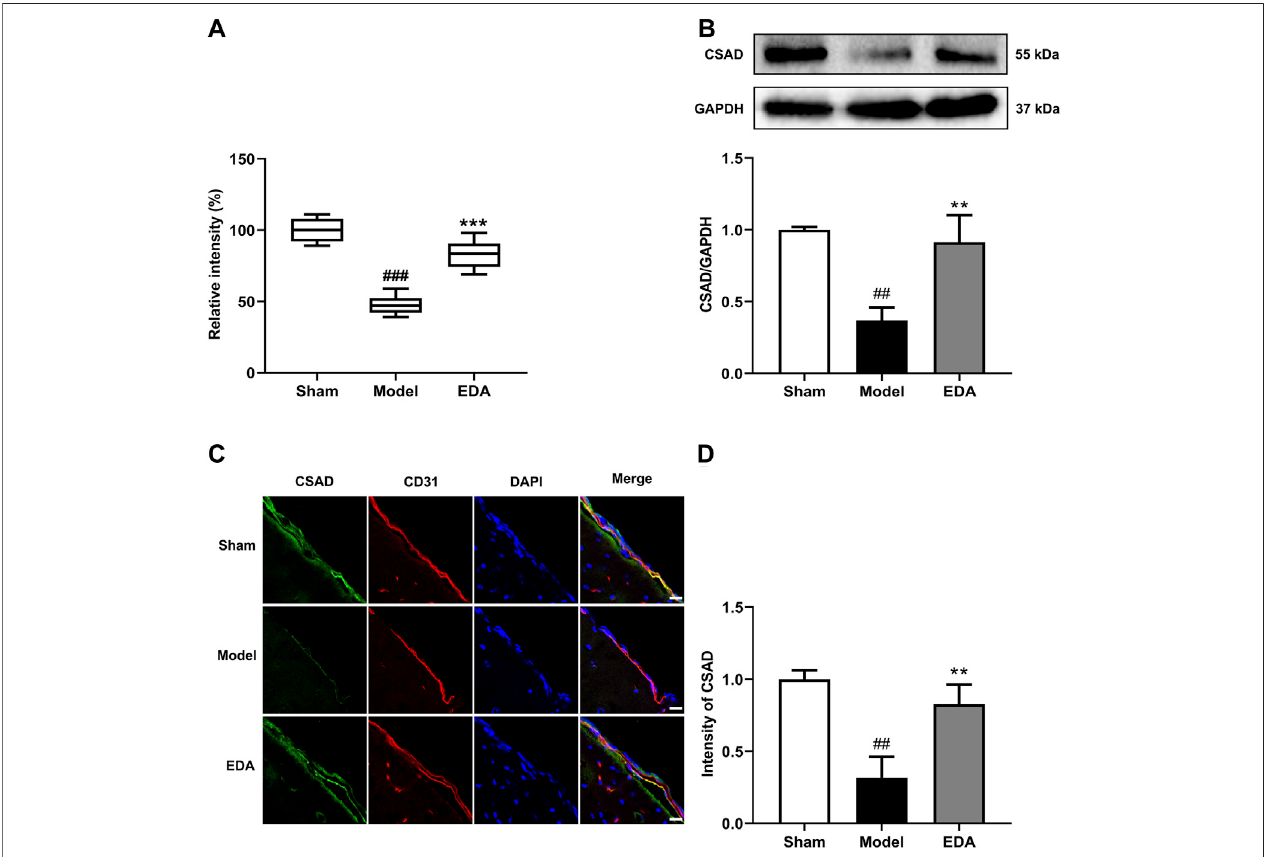
FIGURE 6 | Effect of EDA on taurine and CSAD in MCAO/R mice. (A) Level of taurine in the different groups. (B) Representative Western blots and quantitative analyses of CSAD expression. (C) Immuno fl uorescence staining for CSAD (green) and CD31 (red) were performed on frozen brain sections, and the nuclei were counterstainedwithDAPI(blue)(scalebar=20 μ m). (D) QuantitativeanalysesofCSADexpressioninendothelialcells.Alldataarepresentedasthemeans±SEM, n =6. # p < .05, ## p < .01, ### p < .001, vs. Sham group, * p < .05, ** p < .01, *** p < .001, vs. MCAO/R